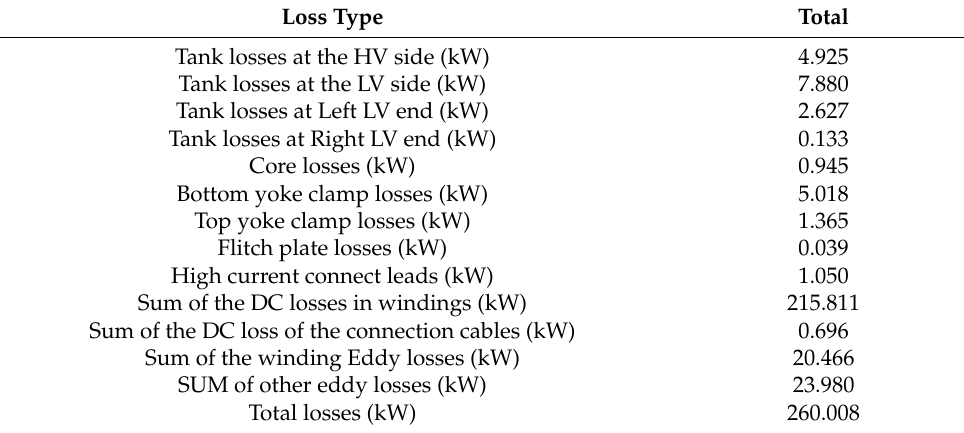
Table 3. Losses in metallic structures—Case